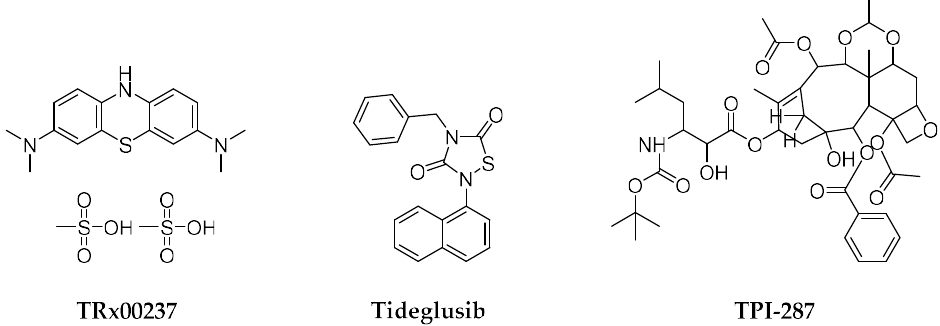
Figure 3. The structures of selective drug candidates for FTD